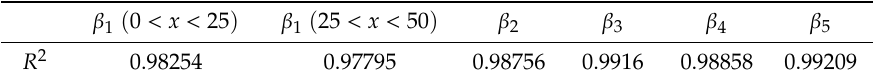
Table 9. The correlation coe ffi cients of five linear equations.